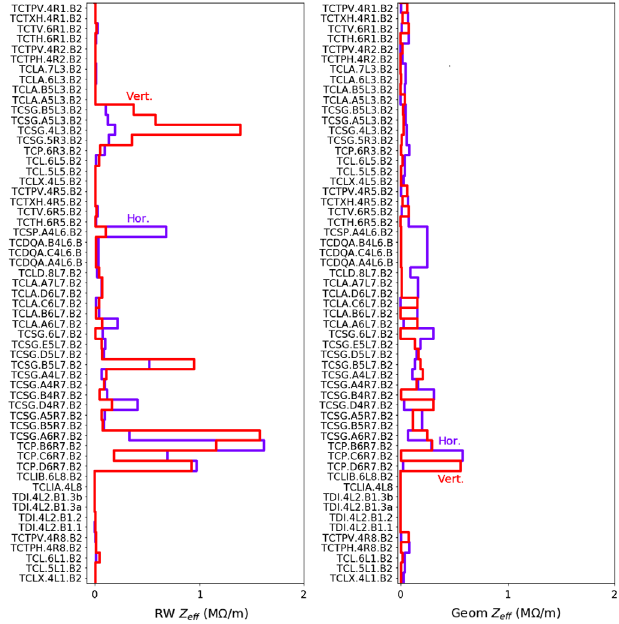
12. Breakdown of the overall dipolar effective imaginary impedance of the machine after the low impedance collimator upgrade by the individual collimators: resistive wall (RW) contributions are shown on the left and geometric (Geom) — on the right. The upgrade includes 2 primary and 9 secondary collimators per beam. Simulations in IW2D [33], top energy E ¼ 7 TeV, β (cid:1) ¼ 41 cm, Q 0 ¼ 10 , Beam 2. Beam 1 collimators have similar impedance. Primary collimator names begin with “ TCP, ” secondary —“ TCSG, ” tertiary —“ TCT ” ; the last digit before the beam ( ‘ B2 ’ in this case) indicates the IR they are installed at. Refer to Fig. 1 for the roles of individual collimators and their positions in the